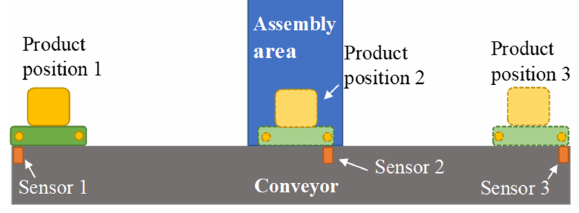
Figure 3. Workstation conveyor sensor placement.